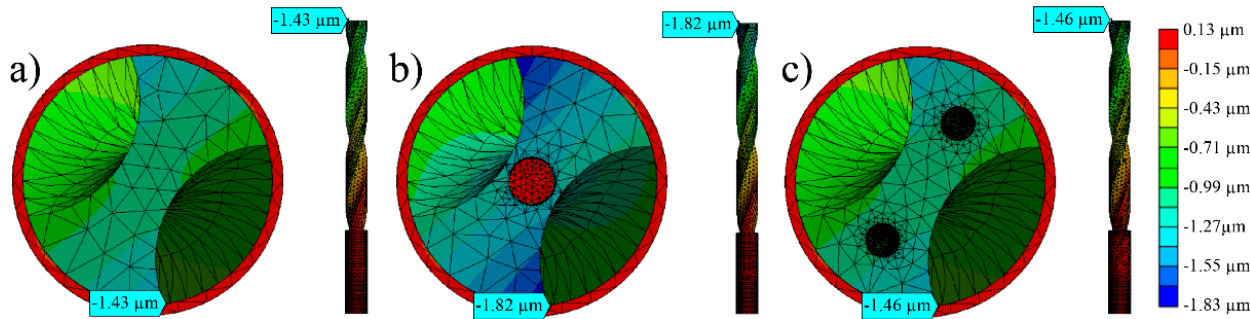
Figure 7. Axial displacement in meters calculated by 3D FEM for the ( a ) solid drill (max: 1.43 μ m), ( b ) drill with a central channel (max: 1.82 μ m), ( c ) two-channel drill (max: 1.46 μ m).